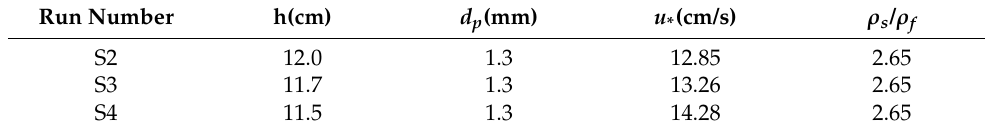
Table 1. Flow conditions of experiments of Einstein and Chien